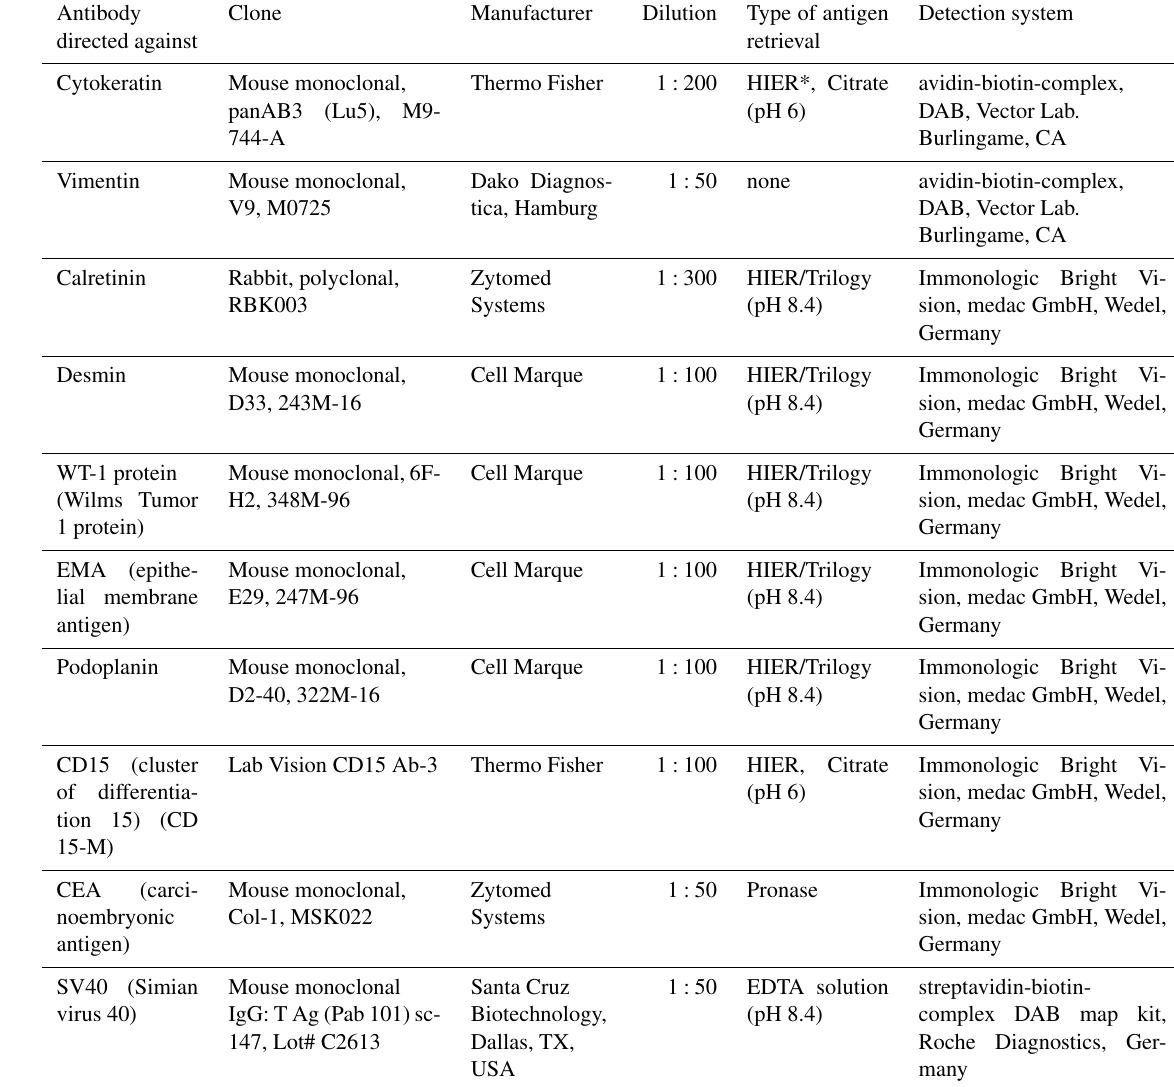
Table 1. Antibodies for Immunohistochemistry. Antibody Clone Manufacturer Dilution Type of antigen directed against